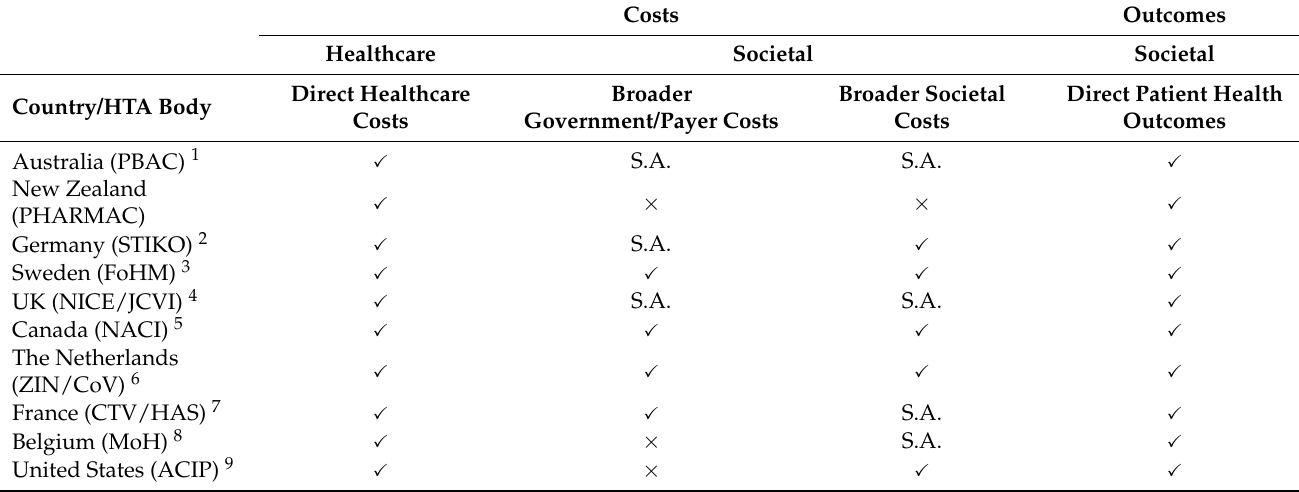
Abbreviations: ‘ACIP’, Advisory Committee on Immunization Practices; ‘CoV’, Committee on Vaccinations; ‘CTV’, Technical Vaccination Commit- tee; ‘HAS’, Haute autorité de santé; ‘HTA’, health technology assessment; ‘JCVI’, Joint Committee on Vaccination and Immunisation; ‘KCE’, Healthcare Knowledge Centre; ‘NACI’, National Advisory Committee on Immunization; ‘PBAC’, Pharmaceutical Benefits Advisory Committee; ‘PHARMAC’, Pharmaceutical Management Agency; ‘S.A.’, sensitivity analysis/supplementary analysis; ‘STIKO’, Standing Committee on Vaccina-